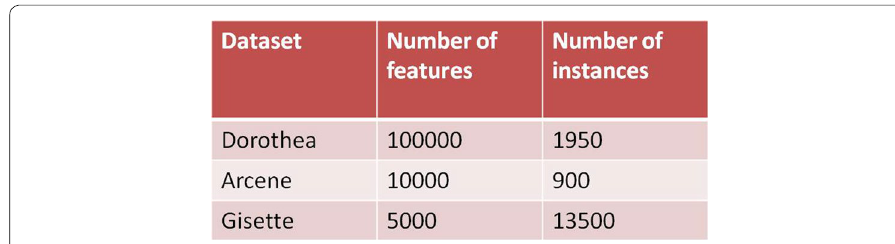
Fig. 4 Datasets characteristics